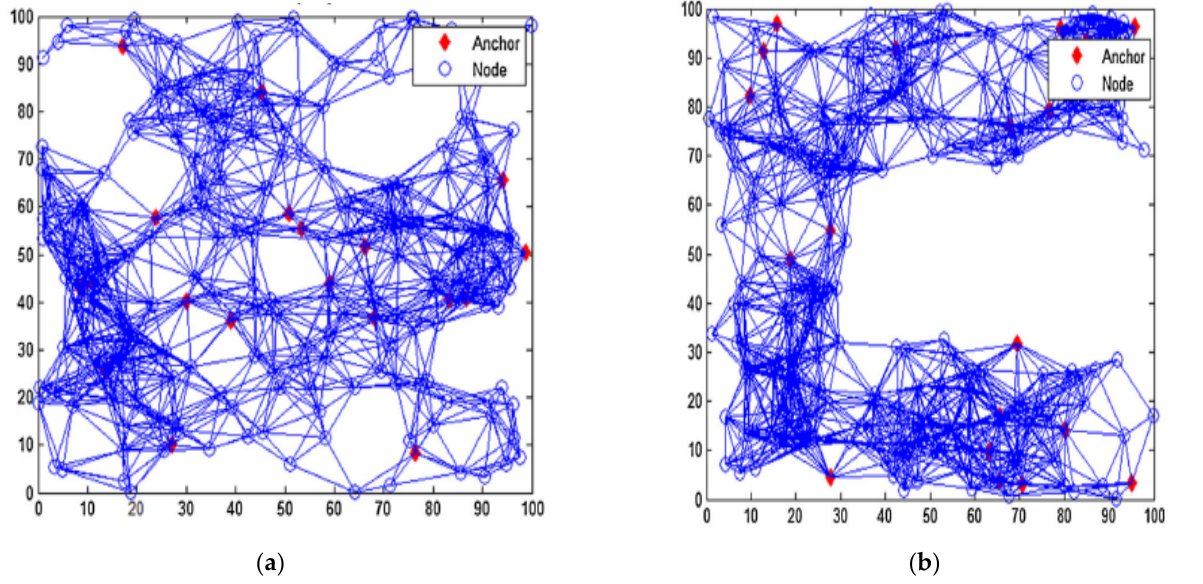
Figure 5. ( a ) Uniform random network; ( b ) C ‐ type random network.